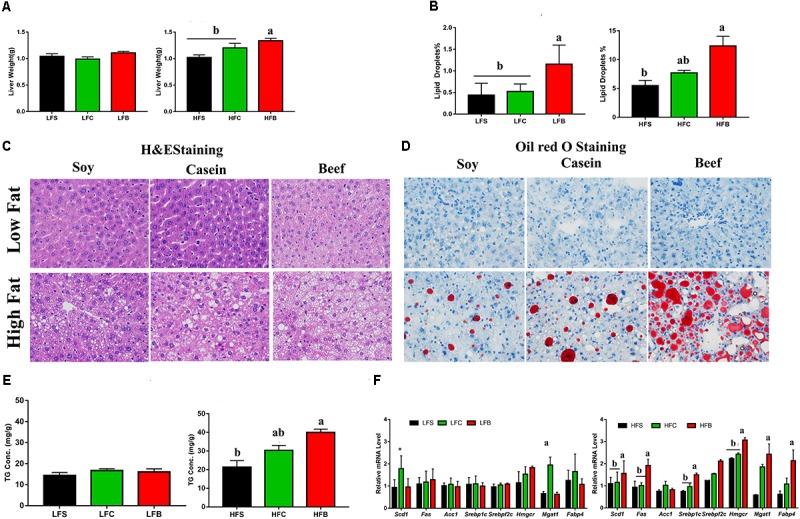
Lipid accumulation in liver: (A) Liver weight at the end of experiment; (B) lipid droplets percentage measured by Oil Red O staining; (C) Liver sections stained with H&E (D) or Oil Red O (original magnifications 400× for H&E and 200× for Oil red O staining); (E) triglycerides concentration in liver; (F) relative mRNA levels of genes involved in hepatic lipid and cholesterol metabolism. Each data point represents the mean ± SE and different letters and numerical asterisks denote statistical significance (P < 0.05). ∗P < 0.05, ∗∗P < 0.01 compared to internal control.